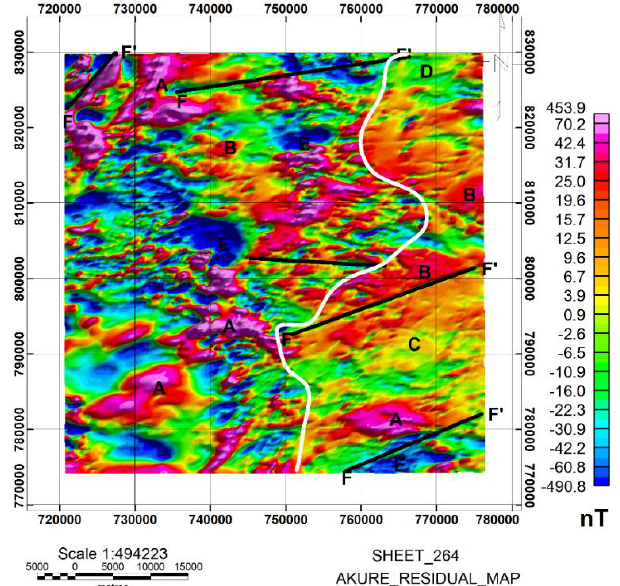
Figure 4: Residual Image produced after the removal of the Regional Field from Total Observed Field